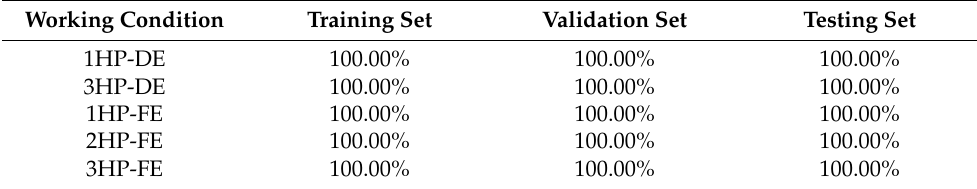
Table 5. Identification accuracy rate of each sample set in different working